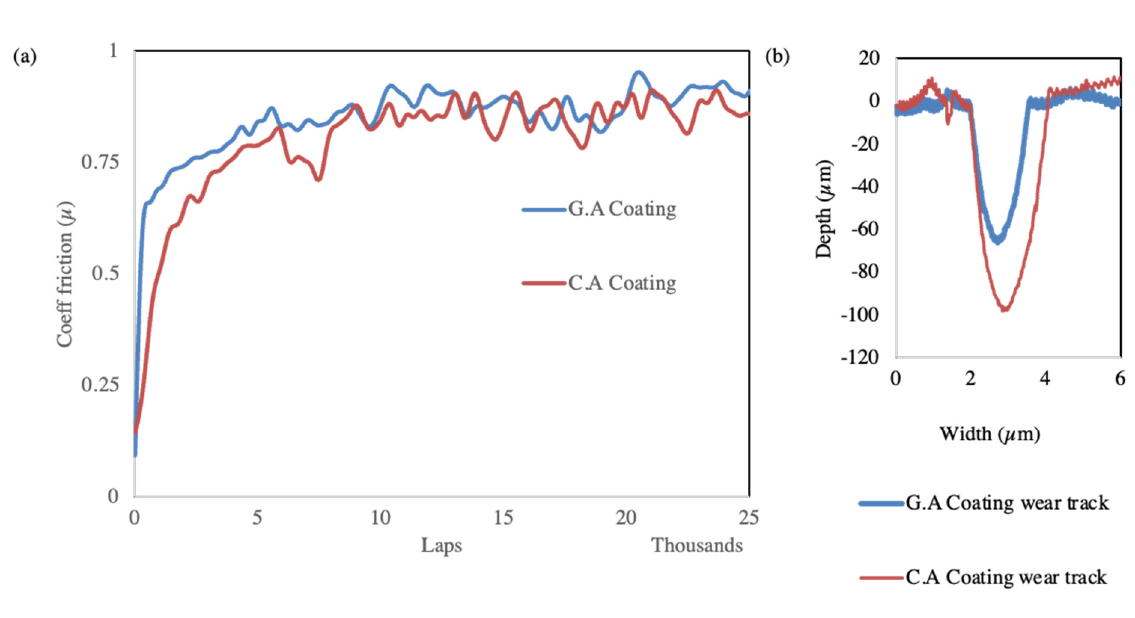
Figure 14. ( a ) Friction coefficients from G.A and C.A coatings over 25,000 laps; ( b ) measured wear track profile from after testing.